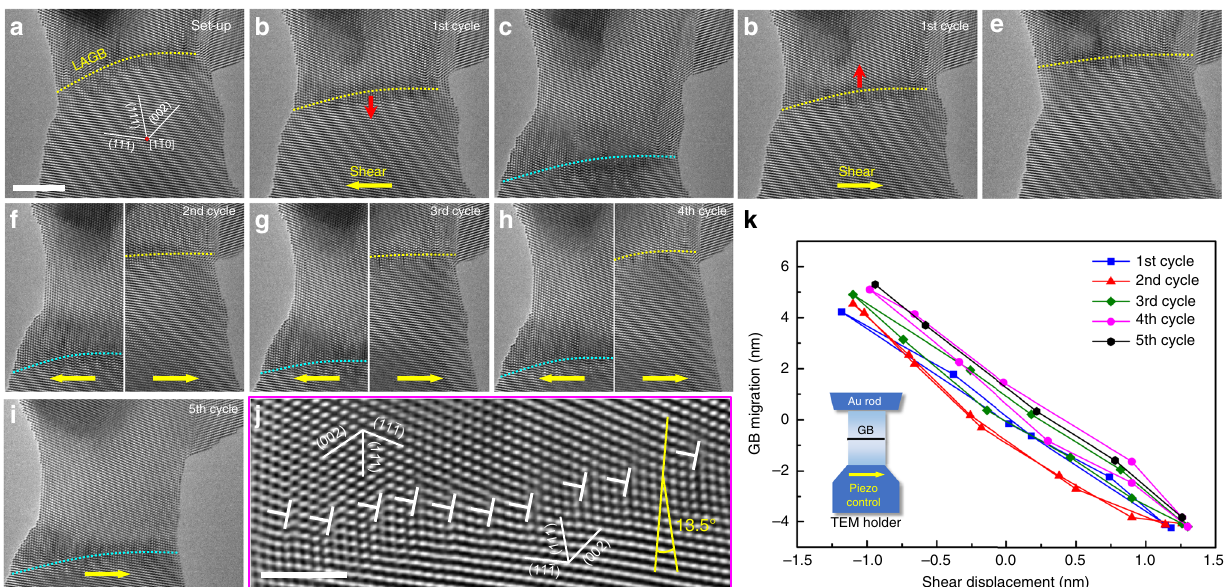
(cid:1) (cid:3) -- Fig. 1 Reversible migration of a 13.5° 1 10 low angle grain boundary (LAGB) in shear loading cycles. a An as-fabricated gold (Au) bicrystal with an LAGB. b , c Downward migration of the LAGB under leftward shear loading. d , e Upward migration of the LAGB under rightward shear loading. The directions of shear loading and GB migration in each cycle are shown by the yellow and red arrows, respectively. f – h Reversible migration of this LAGB in subsequent shear loading cycles. For clear demonstration, the top and bottom positions of the LAGB in each cycle are delineated by the yellow and light blue dotted lines, respectively. i The LAGB after the left shear in the fi fth cycle. j Atomistic structure of the 13.5° 1 (cid:1) 10 ½ (cid:2) LAGB, which consists of aligned (cid:1) (cid:3) dislocations with a Burgers vector of 1/2 011 . k GB migration distance versus shear diplacement of the bottom grain in the fi rst fi ve loading cycles. Scale bars: a 5 nm and j 2 nm.